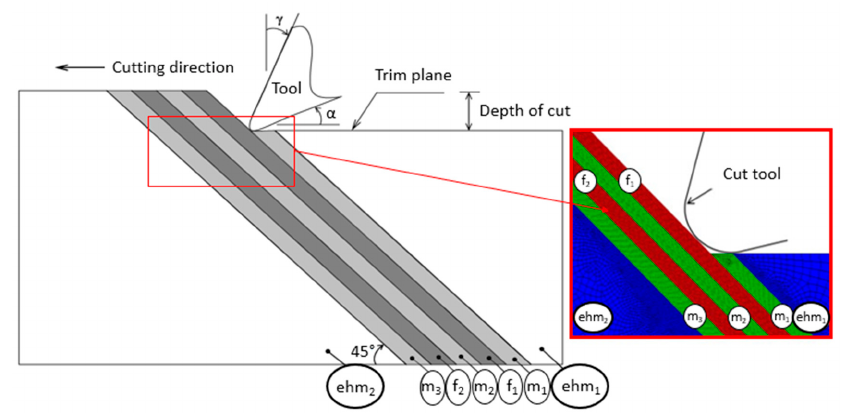
Figure 2. Schematic view of the fiber, matrix and equivalent homogeneous material (EHM) domains used in a finite element model for the case of 45° fiber orientation. Reproduced with permission [30].